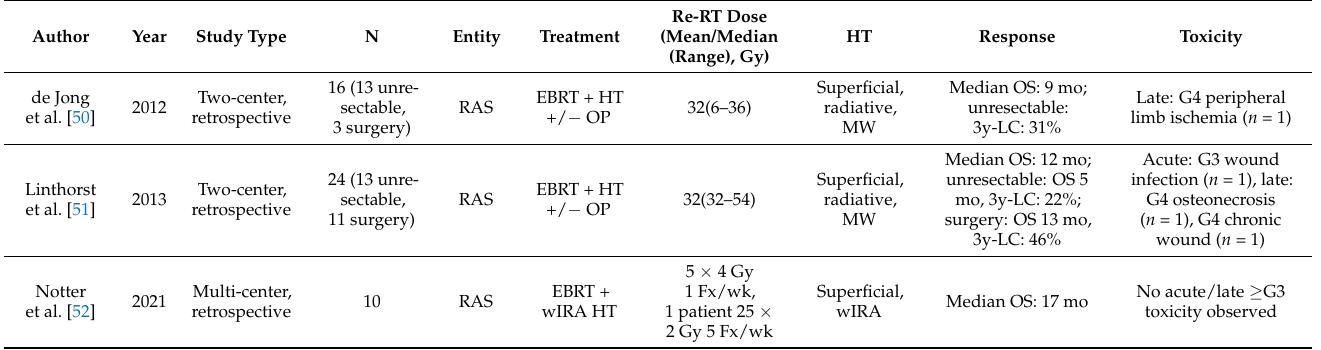
Table 4. Radiation-associated